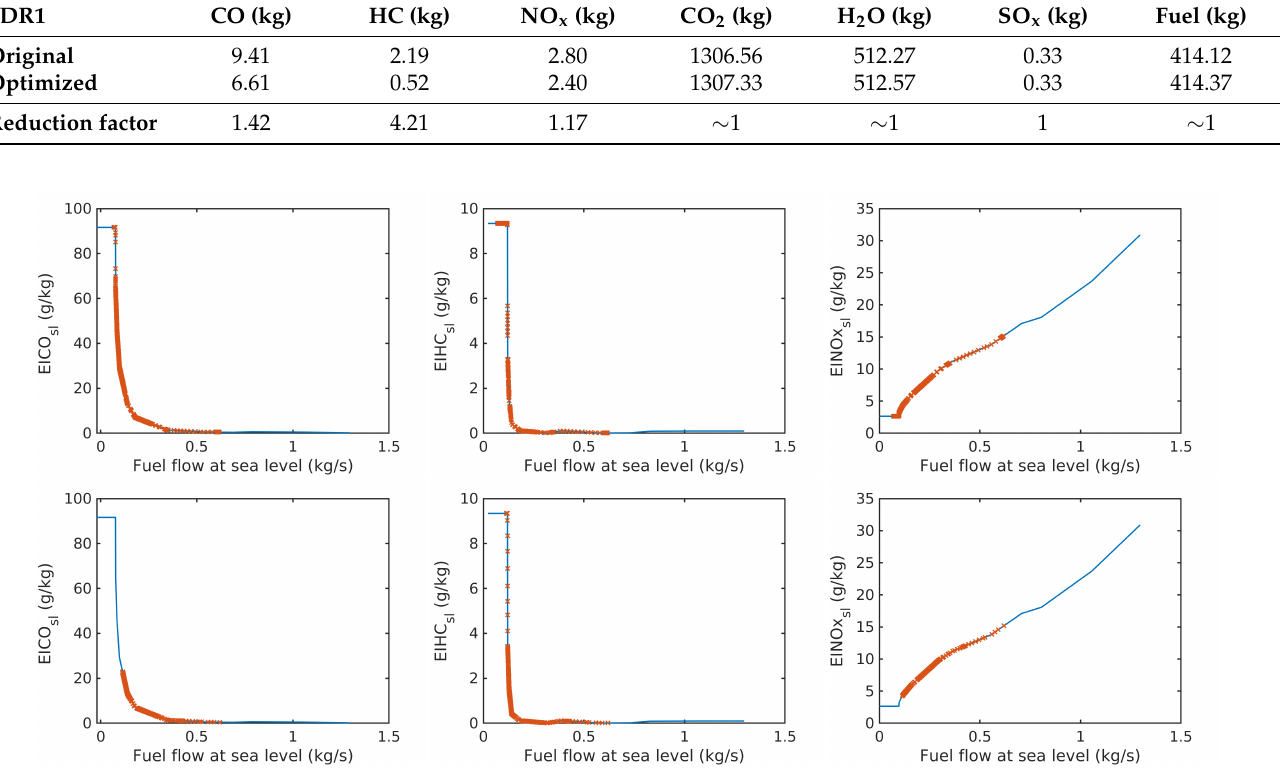
Figure 19. Emissions indices at sea level with respect to fuel flow at sea level for FDR1 trajectory: original ( top ) and optimized ( bottom